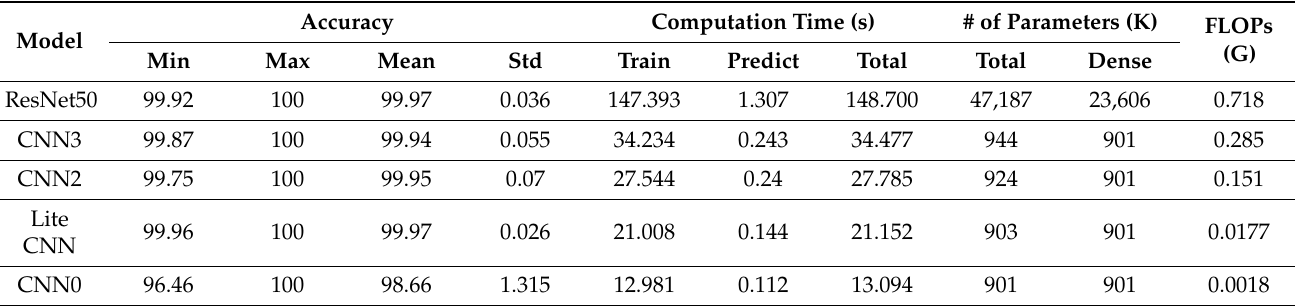
Table 2. Comparison of the bearing fault diagnosis accuracy performance and computational com- plexity measures (computation time, number of parameters, and FLOPs) of models using 65 × 50 size input data.